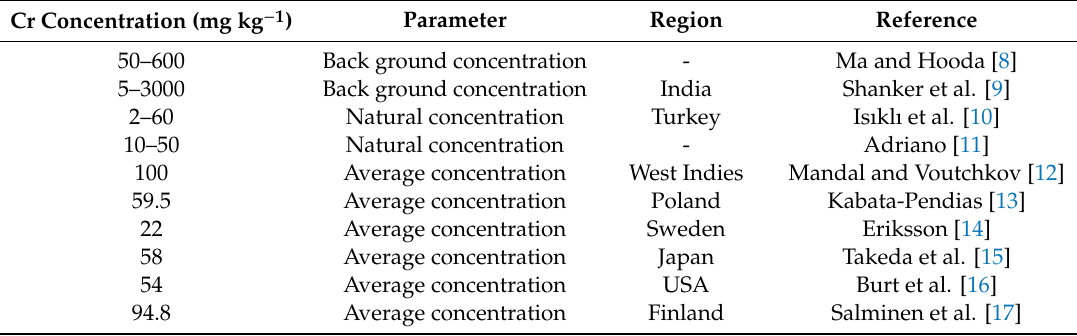
Table 1. Natural and average Cr concentration in soils of di ff erent regions of the world. Cr Concentration (mg kg − 1